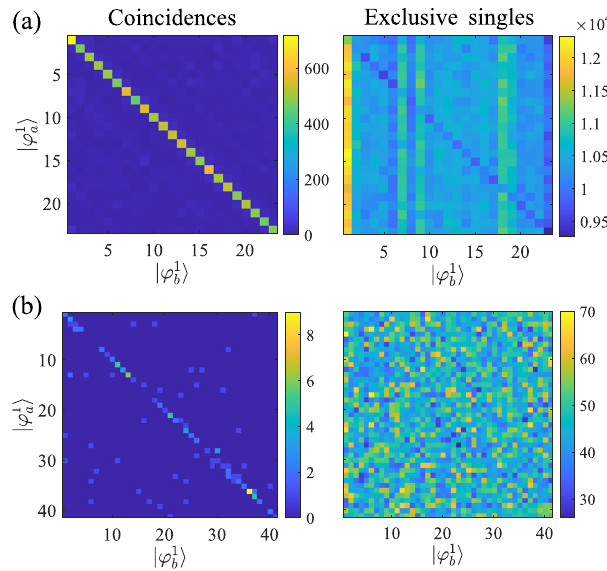
FIG. 6. Time-efficient steering in high dimensions. The coinci- dence counts between Alice and Bob and exclusive single counts measured by Bob in measurement basis x ¼ 1 in dimension (a) d ¼ 23 and (b) d ¼ 41 at a fixed one-sided heralding efficiency of η exp ∼ 0 . 062 , detected with two different acquisition times. Interestingly, even though the counts in d ¼ 41 are 2 orders of magnitude lower than in d ¼ 23 , we still violate the steering inequality with 10 standard deviations in both cases.